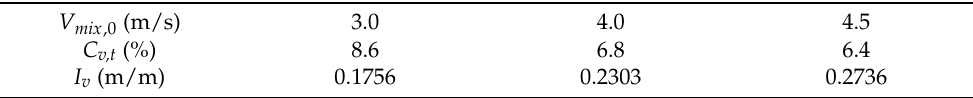
Table 5. Relationship between total pressure drop and initial mixture velocity at C v ,0 = 5% and d s = 15.0 mm.